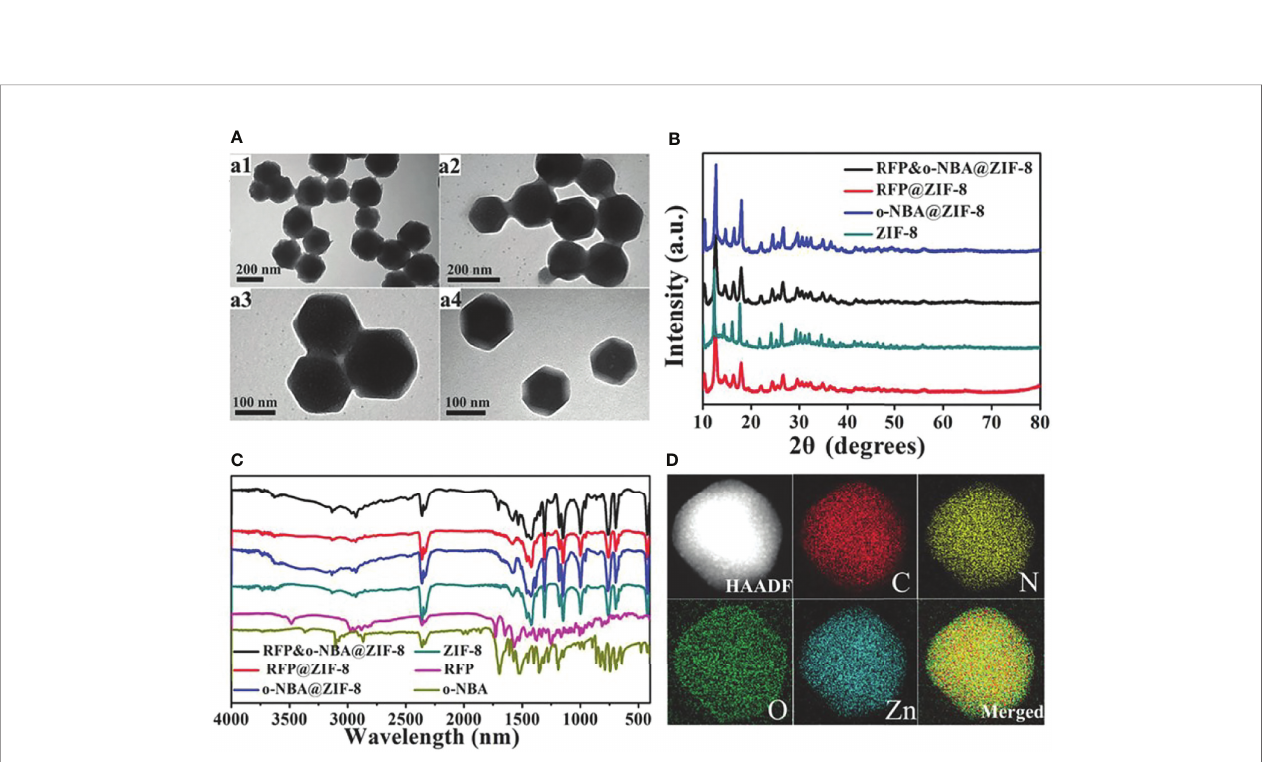
FIGURE 4 | (A) Transmission electron microscopy (TEM) characterization. (B) X-ray diffraction (XRD). (C) Fourier transform IR (FT-IR). (D) (87). Copyright 2018, Wiley. Elemental mapping of